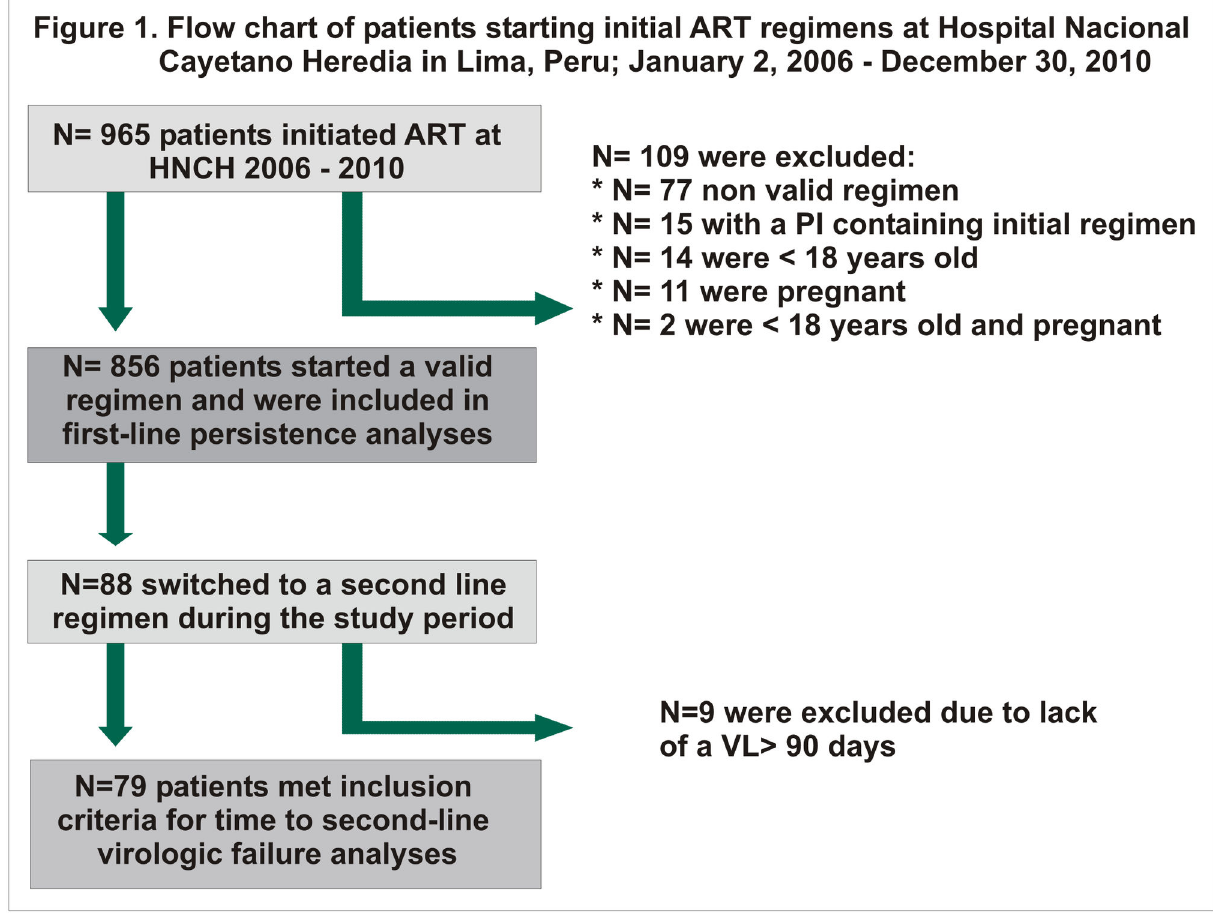
Figure 1. Flow chart of patients starting initial ART regimens at Hospital Nacional Cayetano Heredia in Lima, Peru; January 2, 2006-December 30,2010. doi: